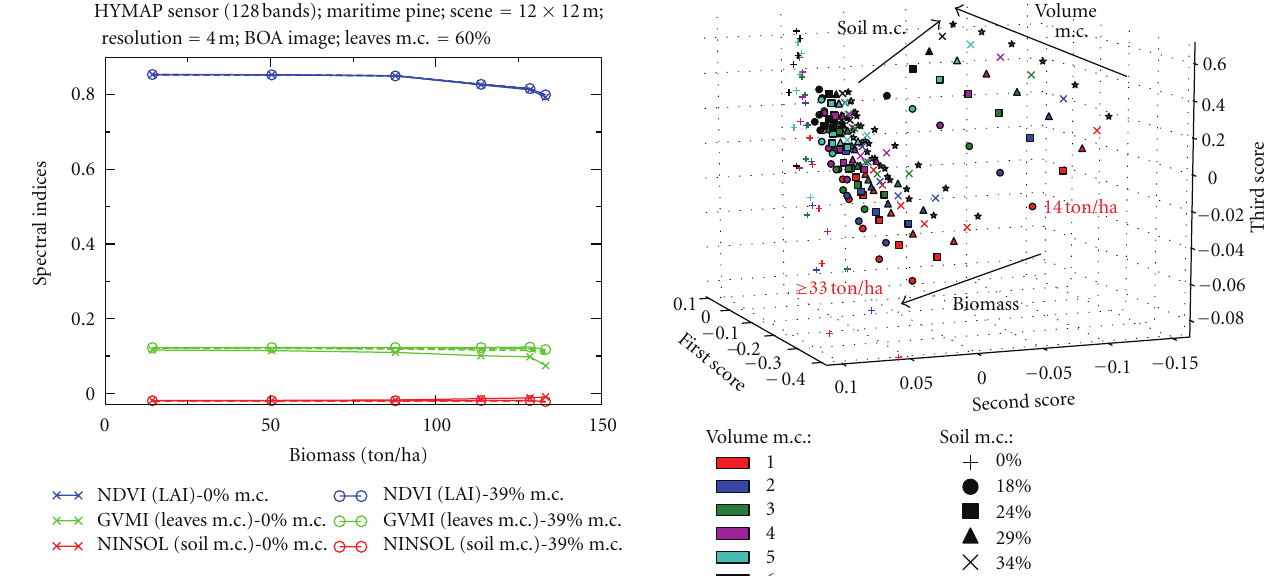
Figure 8: Sensitivity of spectral indices for several biomass and soil moisture content, as given in Table 1.